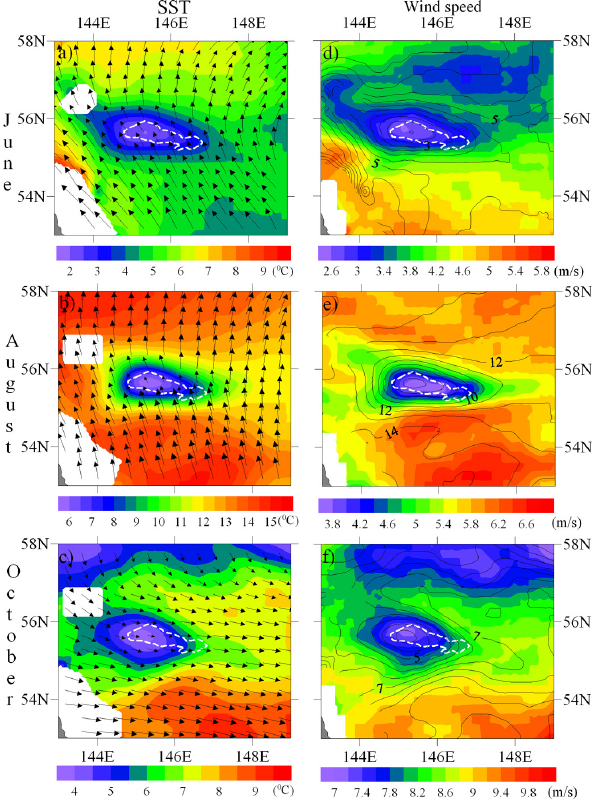
Fig. 1. Monthly average SST (a) – (c) and wind speed (d) – (f) fields during the summer–autumn period in 2006. White dotted line is isobath 200m.